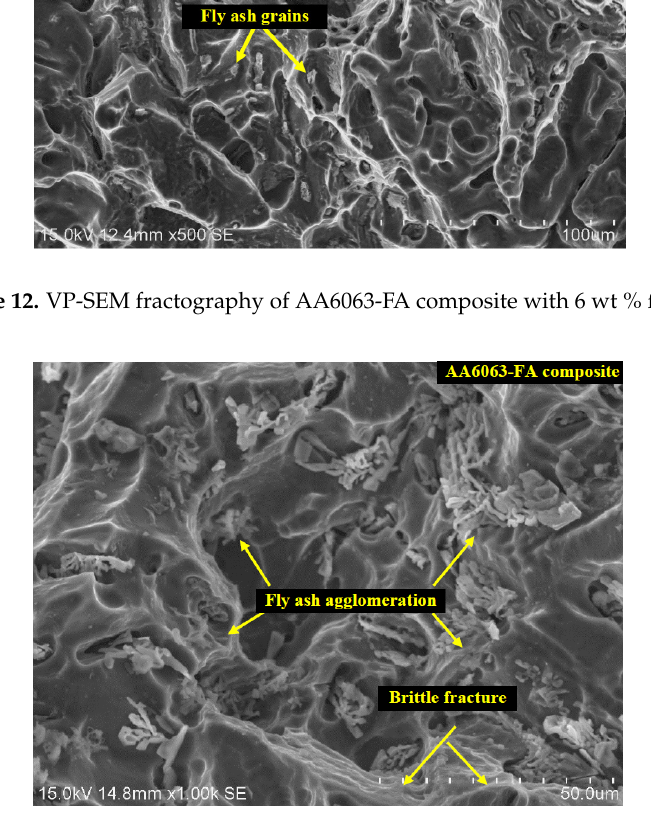
Figure 13. VP ‐ SEM fractography of AA6063 ‐ FA composite with 12 wt % fly ash.